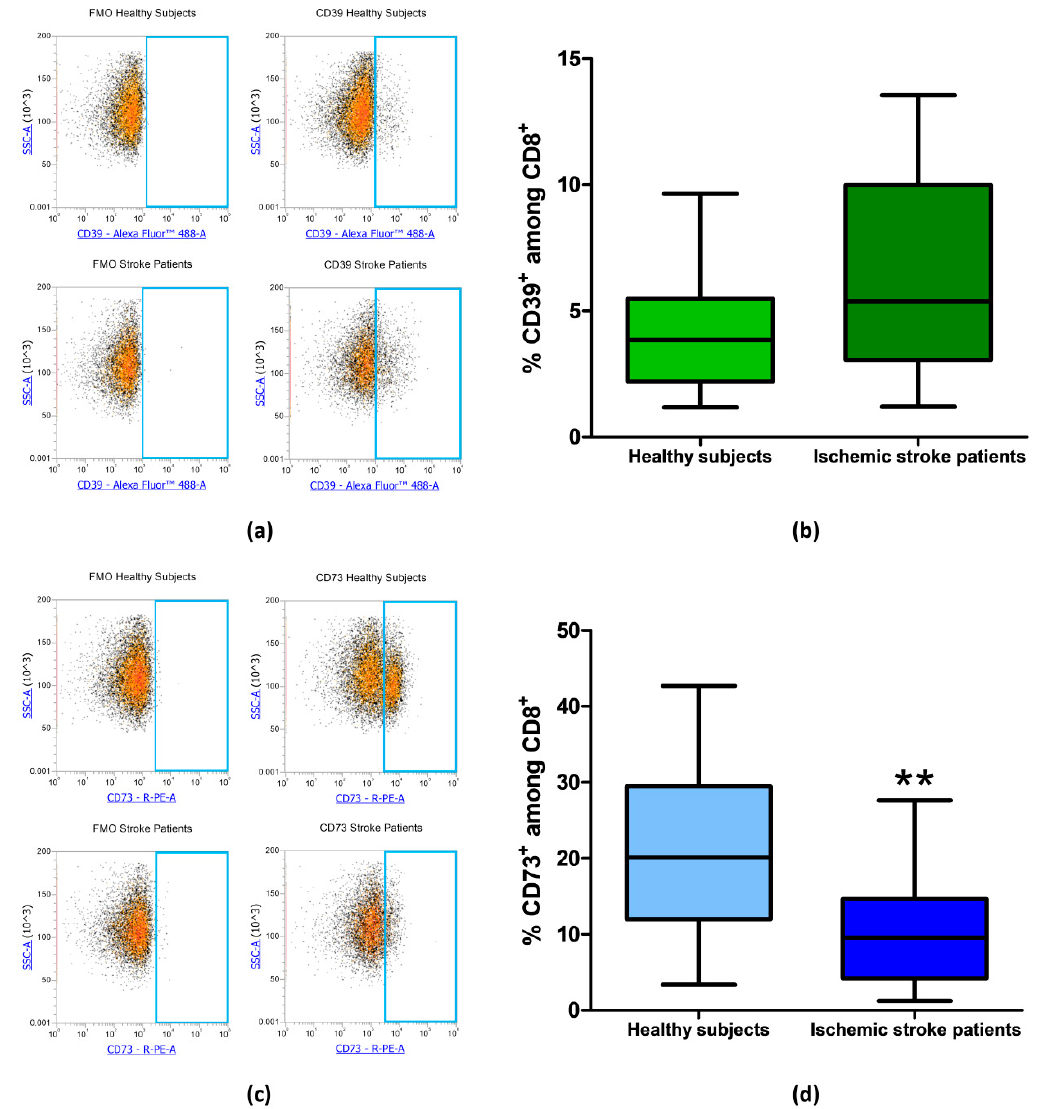
Figure 5. ( a ) Exemplary flow cytometry density plots showing FMO control and CD39 stained cells in CD8 + lymphocytes from healthy subjects and ischemic stroke patients. ( b ) Graphical representation of flow cytometry data showing the CD39 + percentage of CD8 + lymphocytes in healthy subjects (n = 20) and ischemic stroke patients (n = 21) . ( c ) Representative density plots showing FMO control and CD73 stained cells in CD8 + lymphocytes from healthy subjects and ischemic stroke patients. ( d ) Box and Whiskers plot showing the proportion of CD73 + cells among CD8 + lymphocytes in healthy subjects (n = 20) and ischemic stroke patients (n = 21) . Data are shown as the median, interquartile range and the minimum and maximum values. ** p < 0.01 vs healthy subjects.